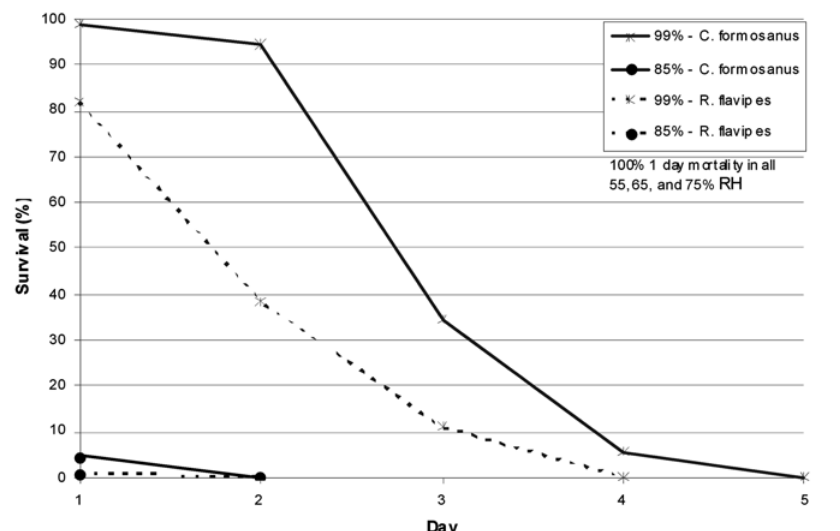
Fig. 6. Survival of small groups (18 workers + 2 soldiers) of C. formosanus and R. flavipes at 35 ° C and varying relative